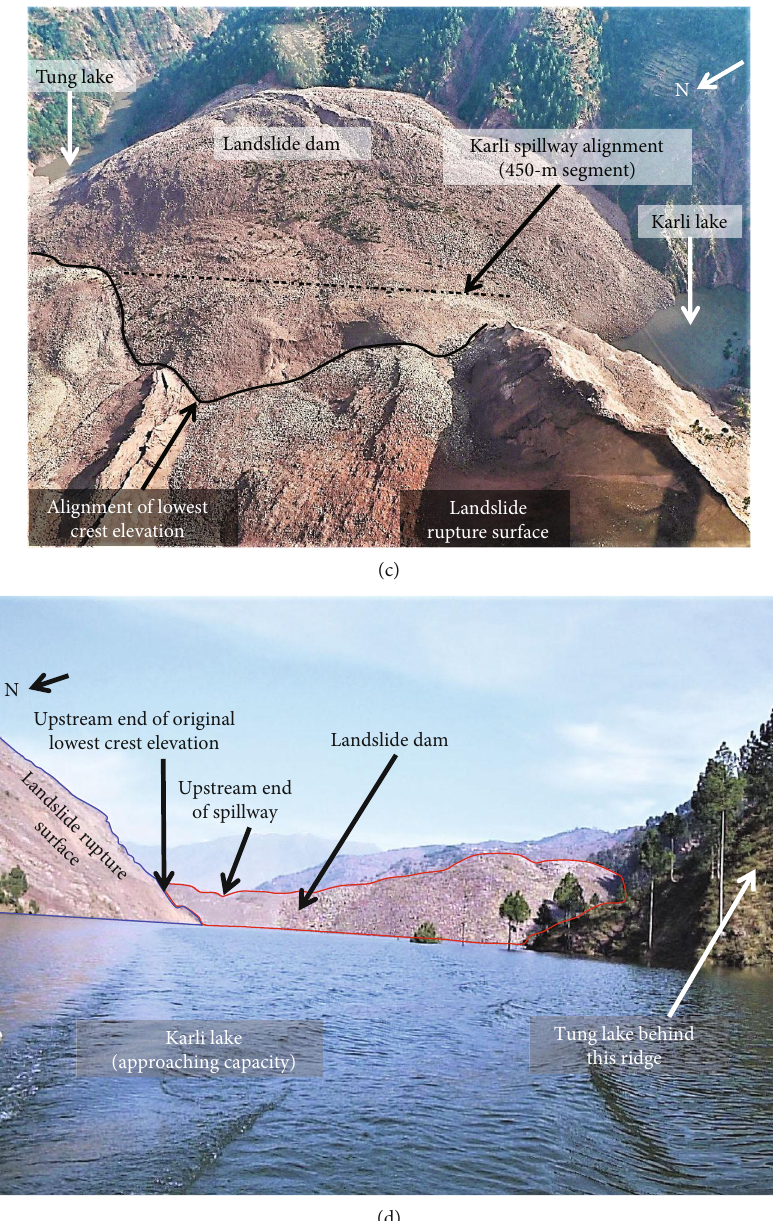
Figure 3: Pictures showing (a) landslide rupture surface and Karli water channel, taken from the upstream side of the dam facing eastward (November 2005); (b) landslide rupture surface, dam, Karli lake, and alignment of the original lowest crest elevation along the dam, taken from the downstream side of the dam facing westward (April 2006); (c) landslide rupture surface, landslide toe, dam, Karli and Tung lakes, and alignments of the original lowest crest elevation and the Karli spillway along the dam surface, taken from the top of the landslide (November 2005); (d) landslide rupture surface, dam, Karli lake, and upstream ends of the original lowest crest elevation and the Karli spillway, taken from Karli lake (December